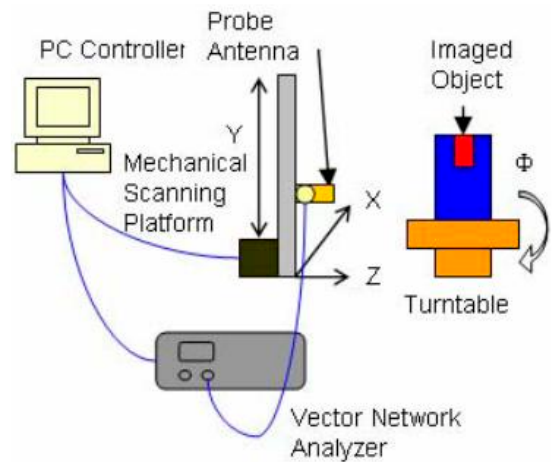
Figure 8. The system configuration of an ultra-wideband (UWB) radar [61].